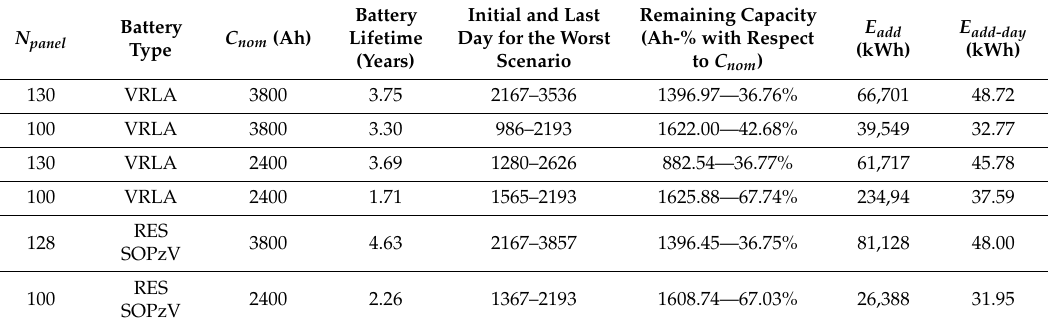
Figure 9. Remaining capacity of the battery with respect to the current days on operation for di ff erent combinations of PVs (100 or 130), battery type (AGM VRLA or gel RES SOPzV), and capacities (2400 or 3800 Ah). Table 9. Battery economic lifetime, initial and last day for the worst scenario, remaining capacity at the end of the battery economic lifetime, the total produced PV energy loss E add for the all economic lifetime, and the mean daily produced PV energy loss E add-day for indicative di ff erent combinations of PVs (100 or 130), battery type (absorbed glass mat (AGM) valve regulated lead acid (VRLA) or gel RES SOPzV), and capacities (2400 or 3800